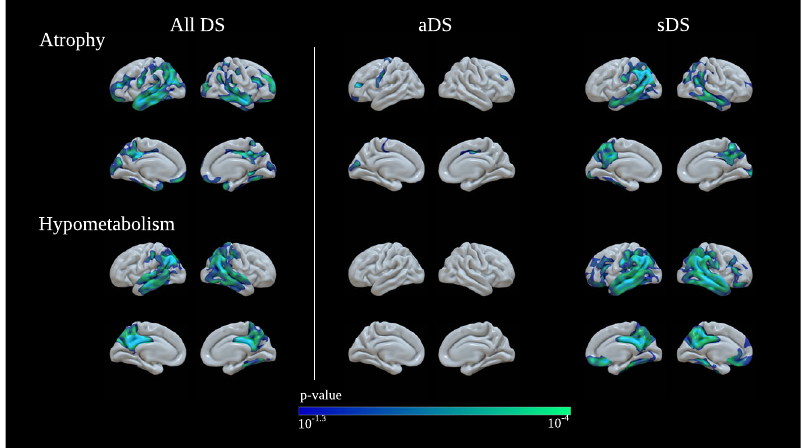
Fig. 3 Association of plasma p-tau181 levels with imaging biomarkers in Down syndrome. a Association of p-tau181 levels with cortical thickness measured by MRI in Down syndrome subjects. Levels of plasma p-tau181 correlated with atrophy in Alzheimer ’ s disease typical regions. b Association of plasma p-tau181 levels with brain metabolism measured by 18 FDG-PET in Down syndrome subjects. Levels of plasma p-tau181 correlated with lower brain metabolism, also driven by patients with symptomatic Alzheimer ’ s disease. aDS asymptomatic Down syndrome, sDS Down syndrome with symptomatic Alzheimer ’ s disease.